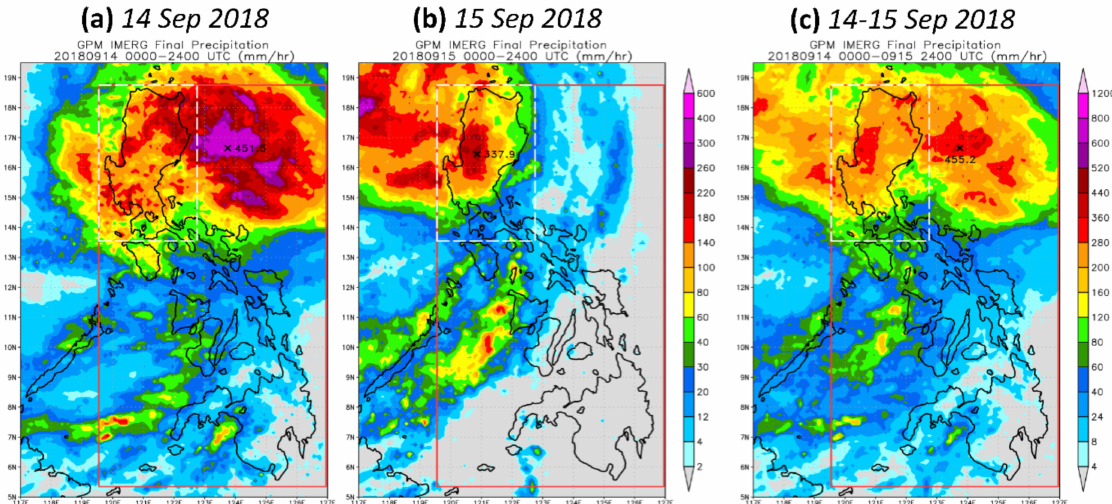
Figure 4. The GPM IMERG rainfall observation (mm, color) over the Philippines for the 24 h period of ( a ) 14 and ( b ) 15 September and ( c ) for the 48 h period of 14–15 September during TY Mangkhut (2018). All times are in UTC. The red and dashed white boxes depict the big and small domains for QPF verification, respectively. The “x” marks the peak rainfall inside the big domain. Panels ( a , b ) use the same color bar plotted on the right side of ( b